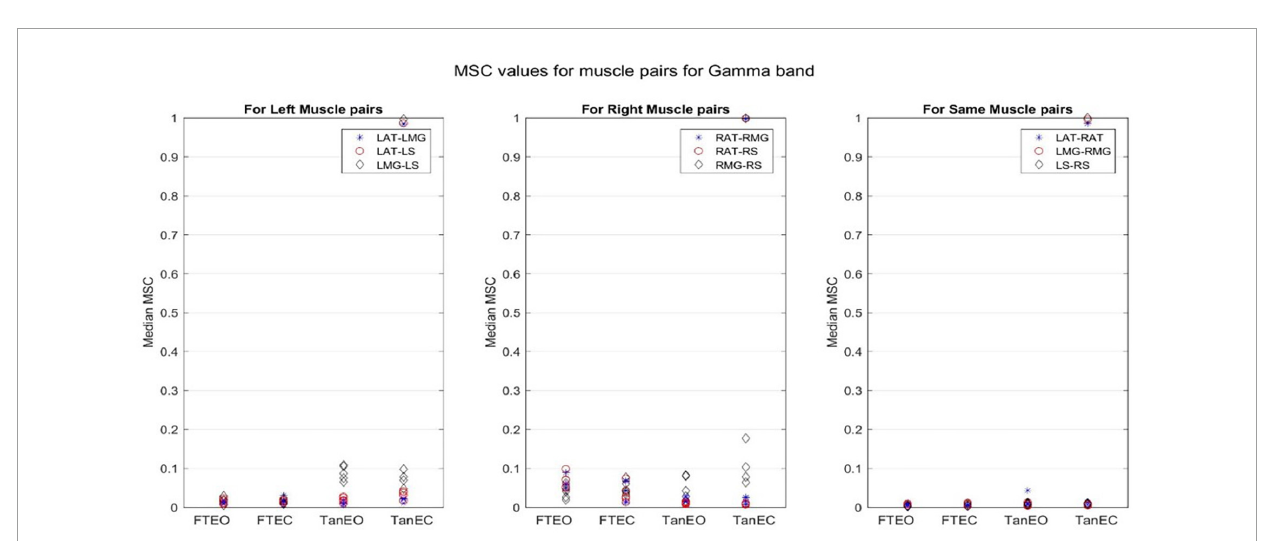
FIGURE4 Magnitude-squared-coherence plot for different muscle pairs under different standing conditions for gamma frequency band (32.8125–103.1250 Hz) for a single participant for all individual trials. The plot shows coherence between different muscle pairs for the most to least stable postural standing positions in the gamma band. Outliers are seen in the data for TanEC conditions.